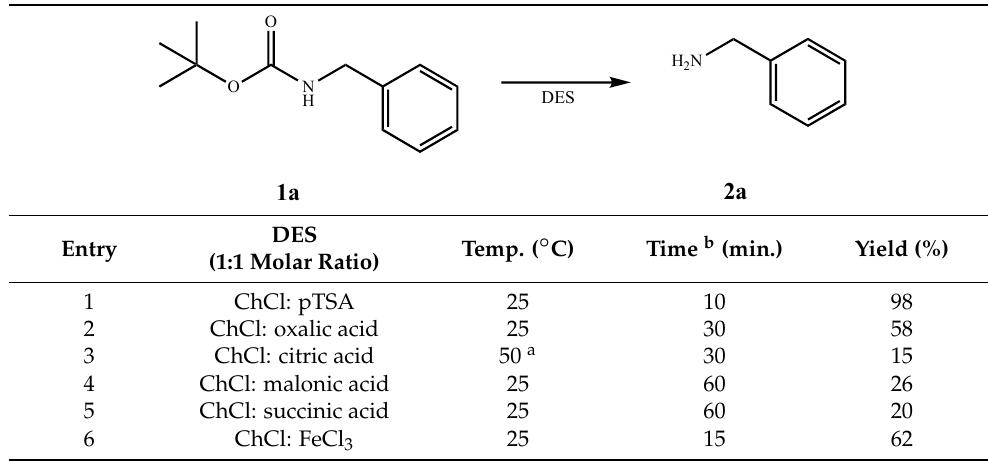
Table 1. Optimization of conditions for the cleavage of N -Boc protecting group.